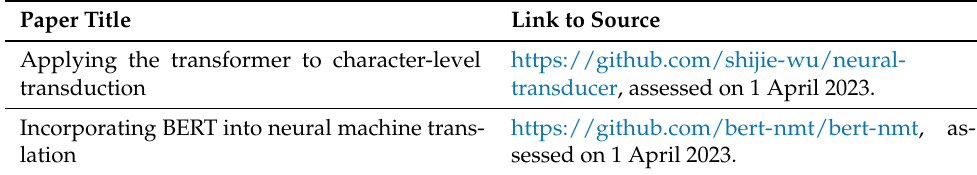
Table 3. Source code links for Machine